Question: What does this figure show? Answer in one sentence.
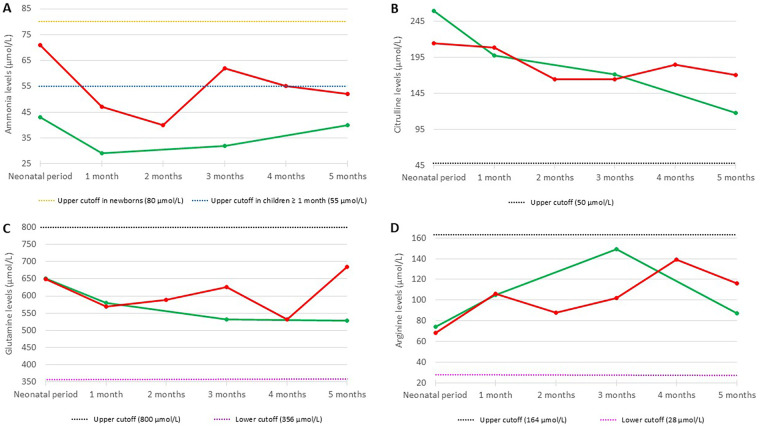
Answer: Ammonia (A) , citrulline (B) , glutamine (C) and arginine (D) plasma levels trends of the two enrolled patients with citrullinemia type 1 (ID 4 -green line, TM- and 5 -red line, NO-TM-) during their first 5 months of life. Dashed lines represent reference limits for age as detailed in the figure ( 24 ). ID, identification number; TM, received nutritional consultations through telemedicine; NO-TM, did not receive nutritional consultations through telemedicine.